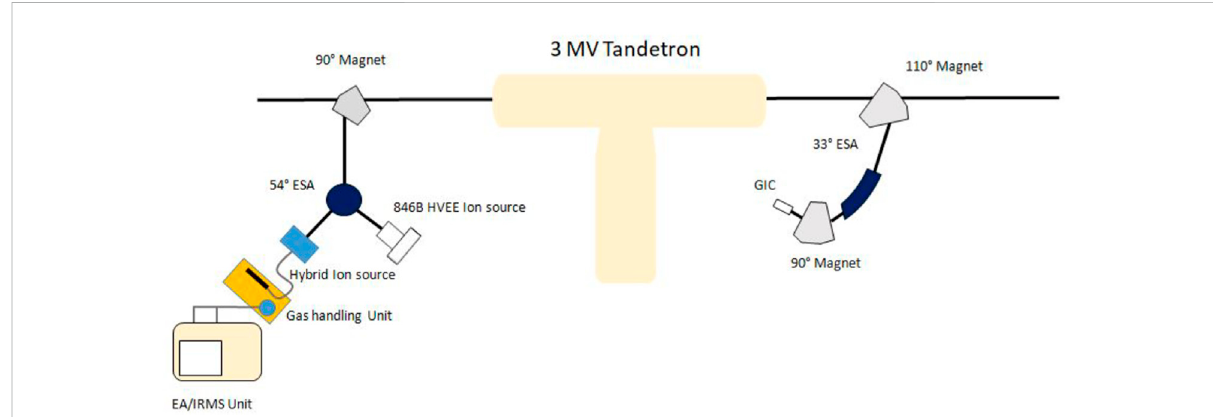
FIGURE 1 The experimental set-up developed at CEDAD (Center of Applied Physics, Dating and Diagnostics) of the Department of Mathematics and Physics,UniversityofSalento,andusedinthisstudy:itisformedbyanElementalAnalyzer(EA),agashandlingunit,ahybridsputteringionsource,and a Tandem accelerator (Mod. 4130HC